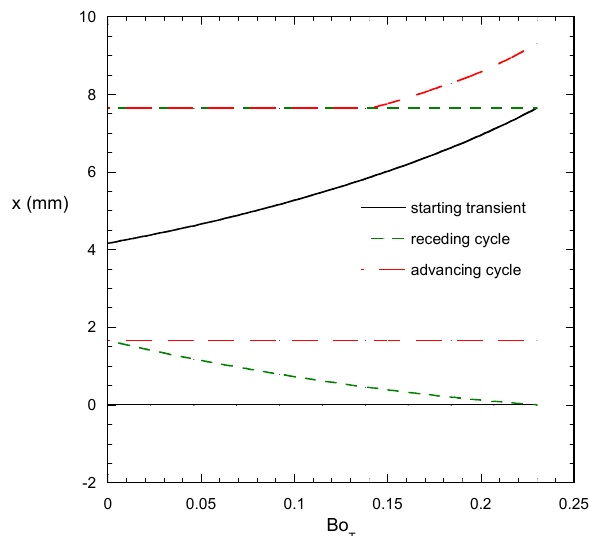
Figure 7. Motion of droplet basis for periodic forcing and Bo N = 12 Bo T (V A = 5 mm 2 , θ a = 60 ◦ , θ r = 40 ◦ , θ o = 60 ◦ ). The curves above x = 3 mm denote the motion of front edge and the curves below x = 3 mm denote the motion of the rear edge of the droplet.